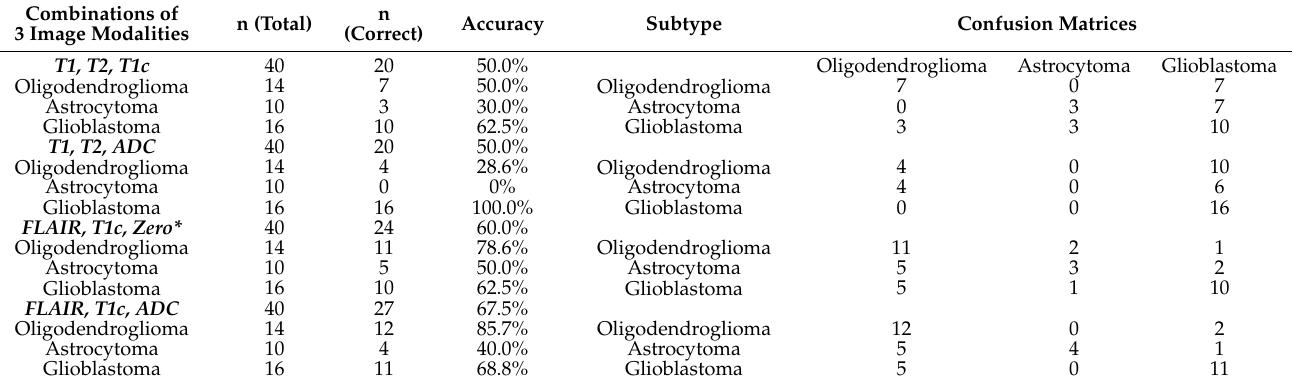
Table 3. Summary of classification results for different sequence combinations on test sets.